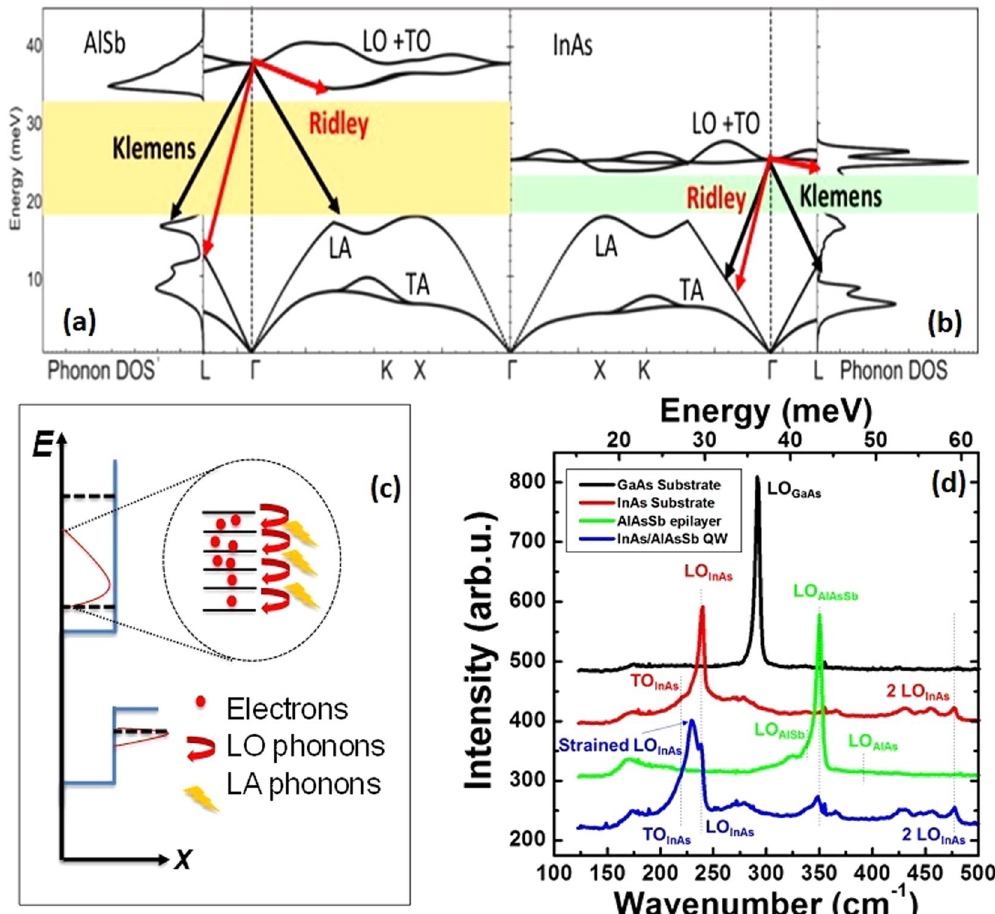
Figure 4. Phonon density of states and dispersion calculated using DFT analysis for ( a ) AlSb and ( b ) InAs. The shaded regions indicate the phonon band gap. Also shown are examples of the Klemens (black) and Ridley (red) relaxation channels. ( c ) The magnified image of the hot electron distribution (full red circles) shown in the dotted circle illustrates the relaxation of carriers through LO phonon emission (solid red arrows) and the subsequent generation of LA phonons (solid yellow bolts). ( d ) Raman spectrum of GaAs (black), InAs (red), and AlAs 0.16 Sb 0.84 (green) reference samples, and the full InAs/AlAs 0.16 Sb 0.84 multi-quantum-well structure